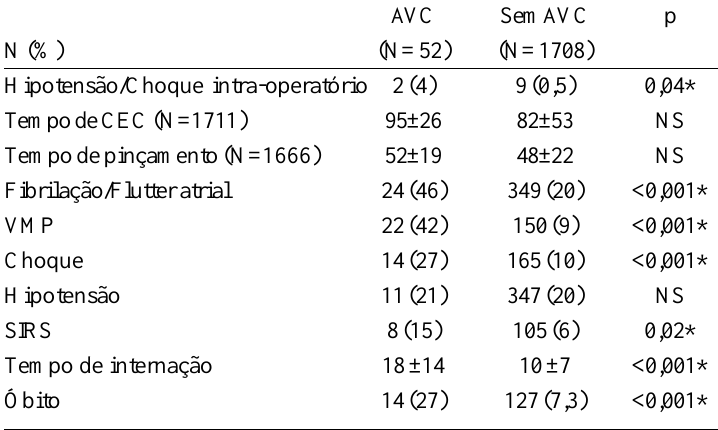
Tabela 2. Variáveis intra e